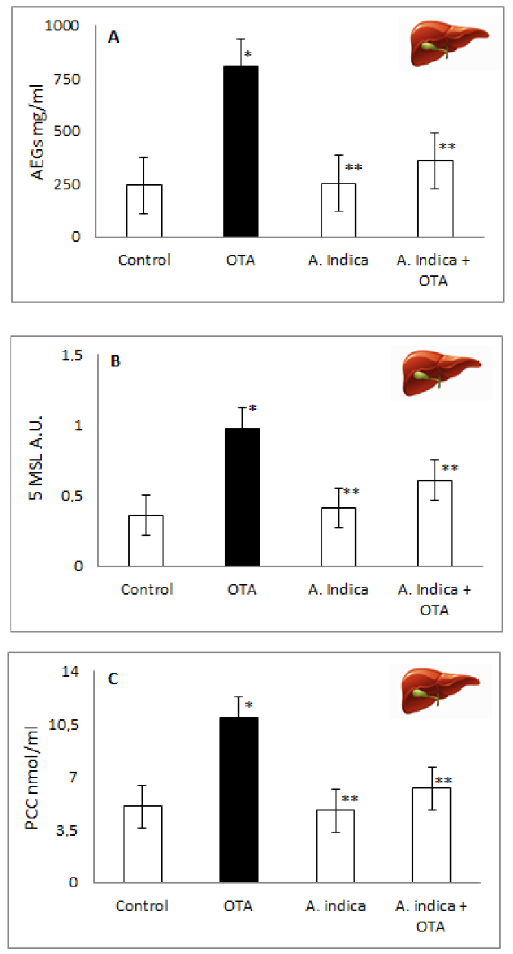
Figure 6. ( A ) AGEs in the group treated with OTA, with A. indica and combination A. indica + OTA, vs. non-treated controls, p < 0.05; ( B ) 5-MSL in the liver of treated with OTA, with A. indica oil only and combination A. indica oil+ mycotoxin vs. healthy controls, p < 0.05; ( C ) PCC in OTA group, A. indica oil group, and group protected with A. indica oil against the mycotoxin OTA, vs. non-treated controls. The presented data as means with SEM. (*) indicate significant differences from (* p < 0.05 vs. control, ** p < 0.05 vs. OTA).